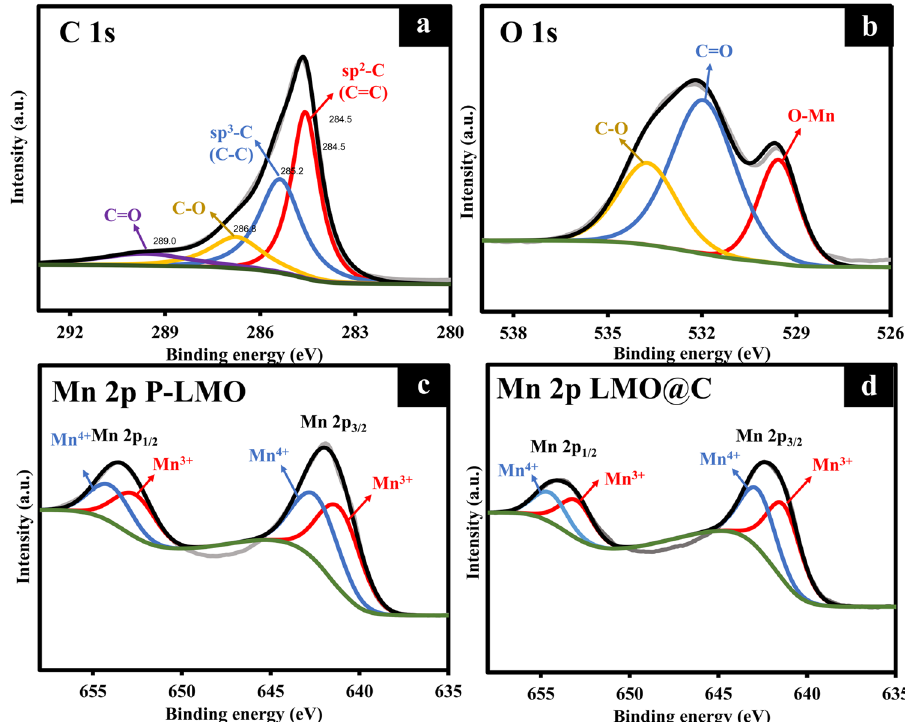
Fig. 2 The elemental composition and the oxidation state of P-LMO and LMO@C. a – d Narrow-scan XPS spectra of ( a ) C 1 s of LMO@C, ( b ) O 1 s of LMO@C, ( c ) Mn 2p of P-LMO, and ( d ) Mn 2p of